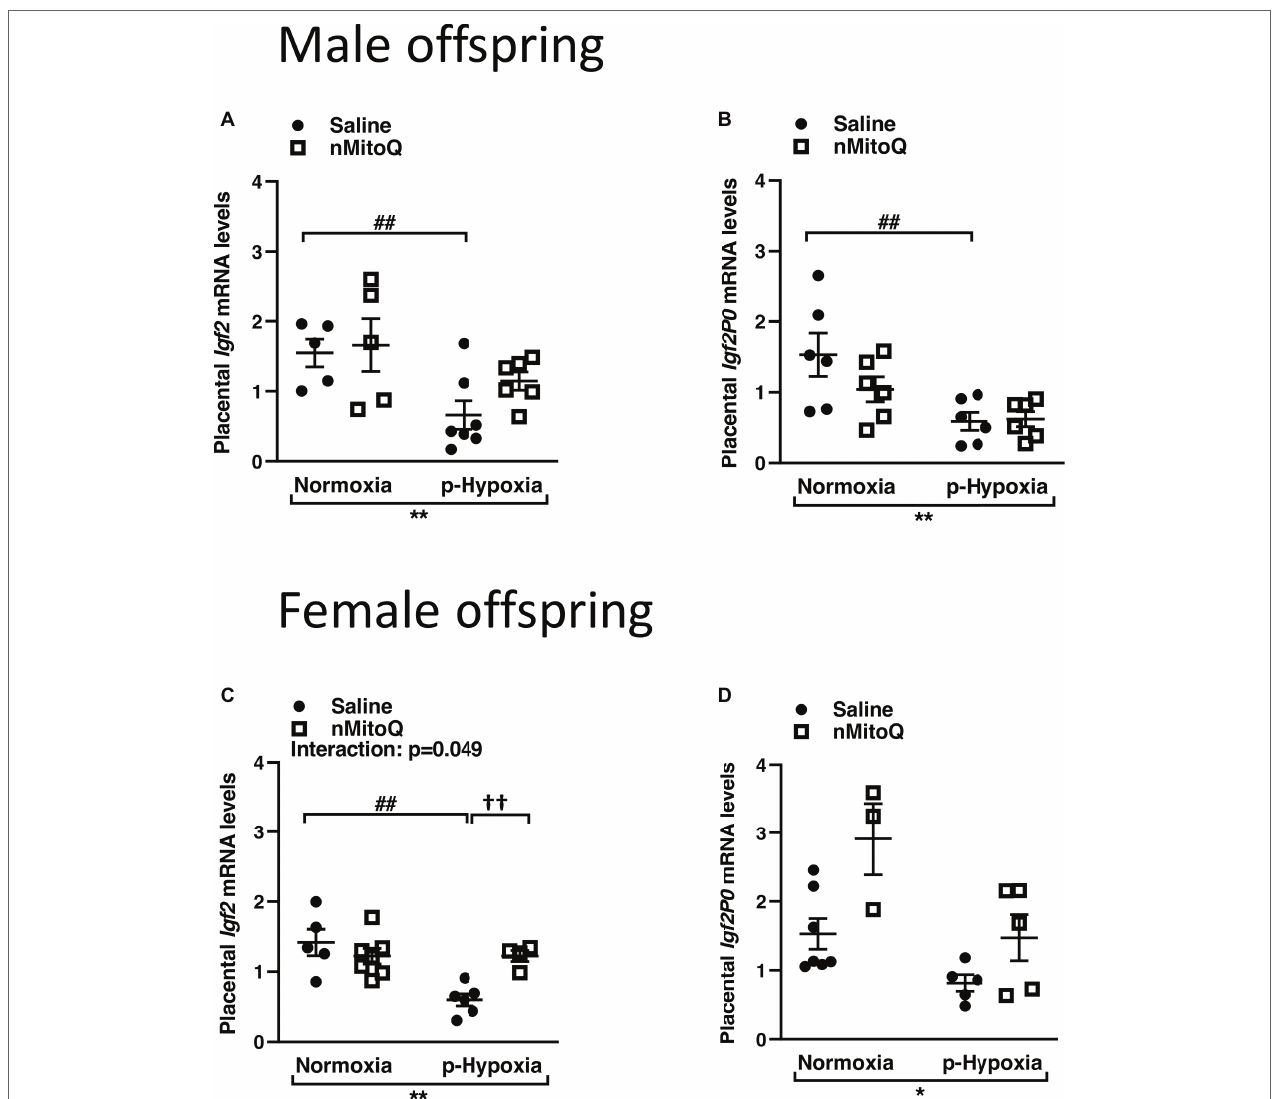
FIGURE 5 | Effects of nMitoQ on placental Igf2 mRNA expression in prenatally hypoxic placentae of both male and female offspring. Growth factor Igf2 (A,C) and Igf2p0 (B,D) mRNA levels as assessed by qPCR in placentae obtained from male (A,B) and female (C,D) fetuses on GD21. Data are represented as mean ± SEM. All groups were compared using a two-way ANOVA followed by Sidak’s post hoc test ( n = 5–9/group). * p < 0.05, ** p < 0.01 group effect of prenatal hypoxia; ## p < 0.01 compared to normoxia-saline; †† p < 0.01 compared to hypoxia-saline